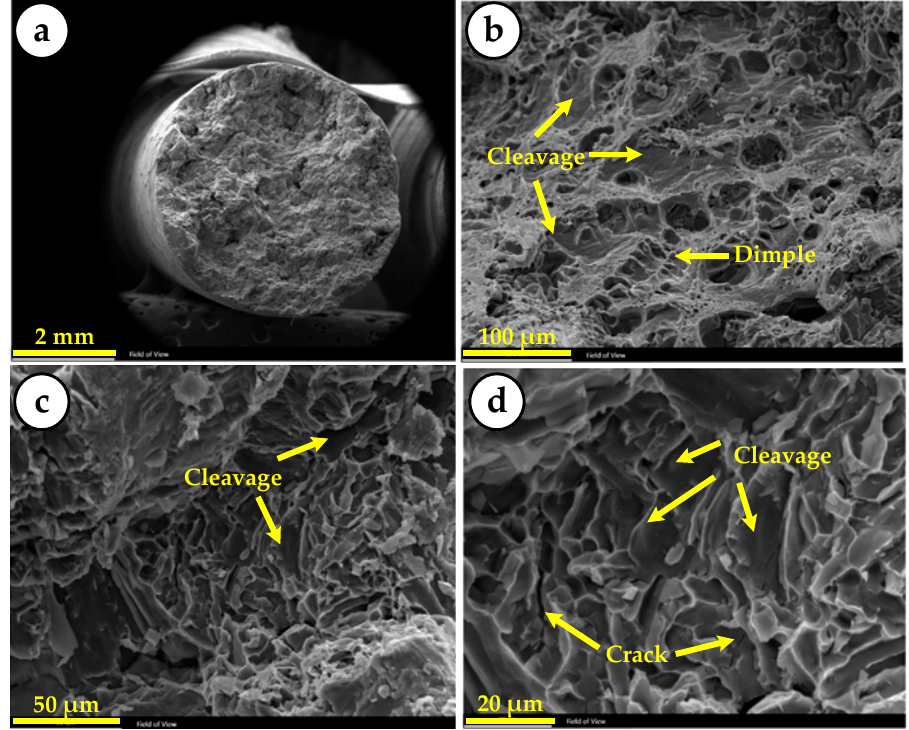
Figure 8. SEM micrographs of the fractured surface of COMP0, ( a ), at different scales of 100 µm ( b ), 50 µm ( c ), and 20 µm ( d ).